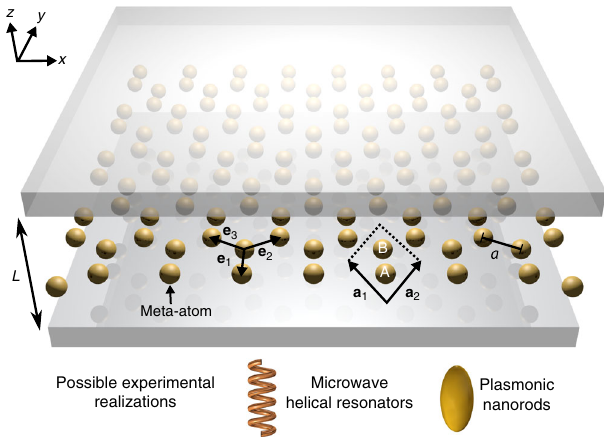
Fig. 1 Schematic of a cavity-embedded honeycomb metasurface. The honeycomb array of meta-atoms is composed of two inequivalent (A ffiffi p ; 3 Þ 3 and B) hexagonal sublattices — de fi ned by lattice vectors a 1 ¼ a ð(cid:4) ffiffi p 2 2 ; 3 Þ — which are connected by nearest-neighbor vectors 3 and a 2 ¼ a ð ffiffi ffiffi p p 2 2 ; 1 Þ , and e ¼ a ð(cid:4) ; 1 Þ , where a is the 3 3 e 1 = a (0, − 1), e 2 ¼ a ð 3 2 2 2 2 subwavelength nearest-neighbor separation. Each subwavelength meta- atom is modeled as an electric dipole, oriented normal to the plane of the lattice. The honeycomb metasurface is then embedded inside a photonic cavity of height L , which is composed of two perfectly conducting metallic plates, enabling one to modify the photonic environment while preserving the lattice structure. This general model can be readily realized across the electromagnetic spectrum, from arrays of plasmonic nanorods